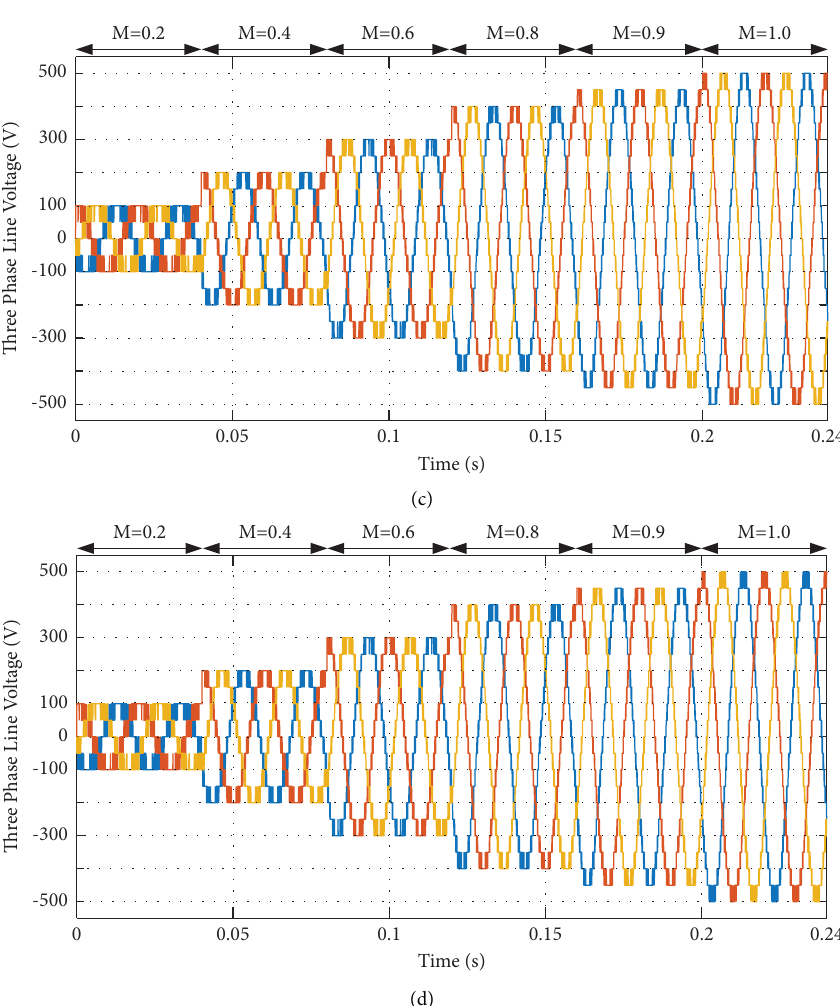
Figure 13: 11L CHB inverter three phase line voltage for dynamic values of M . (a) SPWM. (b) THIPWM. (c) SVPWM-I. (d)